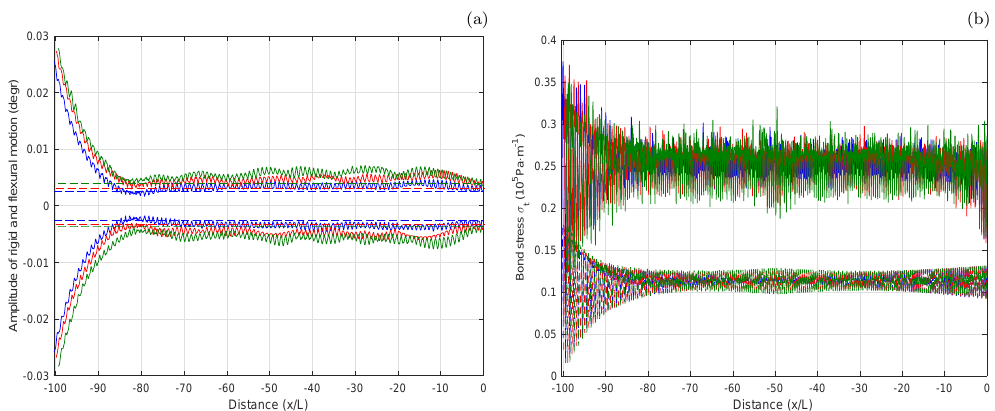
Figure 13. As in Fig. 12e, f, i.e., for n 0 = 100, but for a floe with the right end “frozen” (see text). The distance along the floes is measured relative to the floes’ right edges.